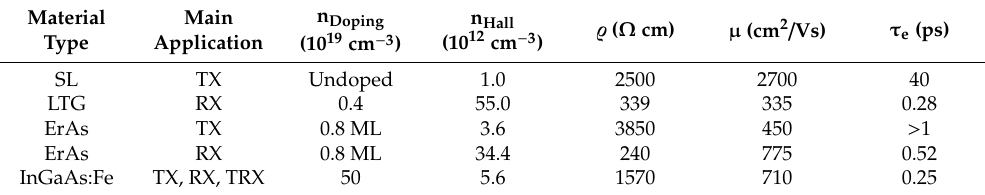
Table 1. Summary of the electrical and dynamic properties of different photoconductors that are commonly used as THz antennas. ρ , µ, and τ e denote the resistivity, electron Hall mobility, and electron lifetime, respectively. Commercially available THz emitters based on an InGaAs/InAlAs superlattice [12] are abbreviated as SL, THz receivers based on LTG-InGaAs:Be/InAlAs:Be [13] are called LTG. THz antennas based on the InGaAlAs/ErAs material system were presented in [11], where 0.8 mono-layers (ML) of ErAs were deposited in a superlattice.